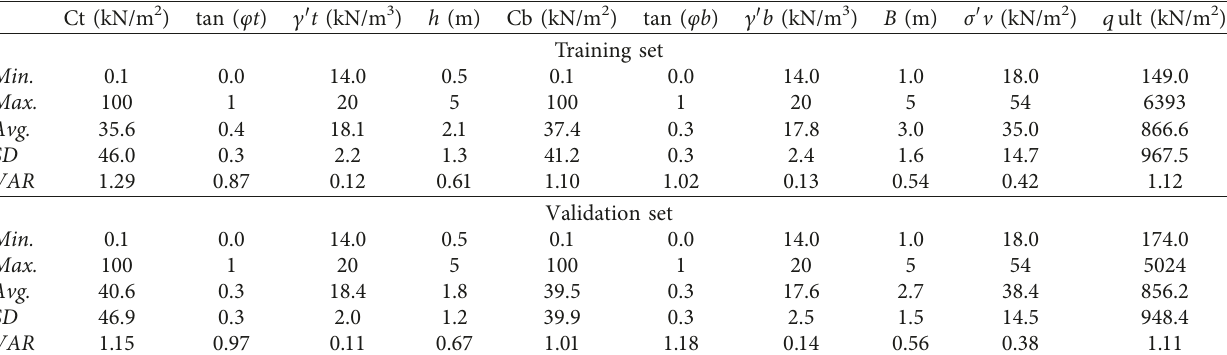
Figure 2: Sample of the FEM model and its output. Table 2: Statistical analysis of collected database.